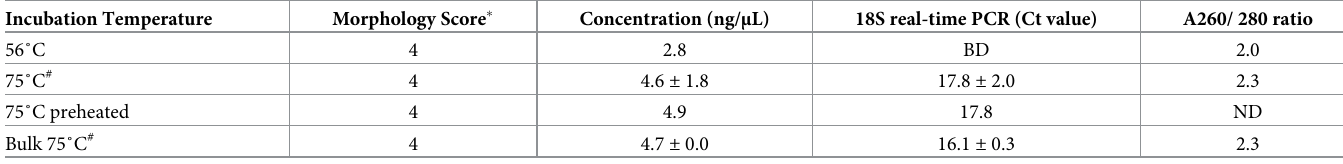
Table 3. Evaluation of rapid lysis method (i.e., 10-minute incubation at increased temperature) on fruit fly morphology, DNA yield and quality (ND = No Data; BD = below detection).